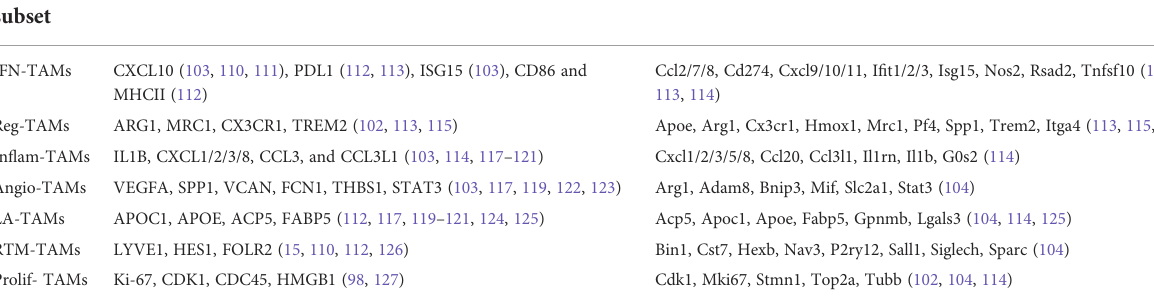
TABLE 2 Non-Exhaustive Signature Genes and Markers for Tumor-associated Macrophage (TAM) Diversity. TAM subset